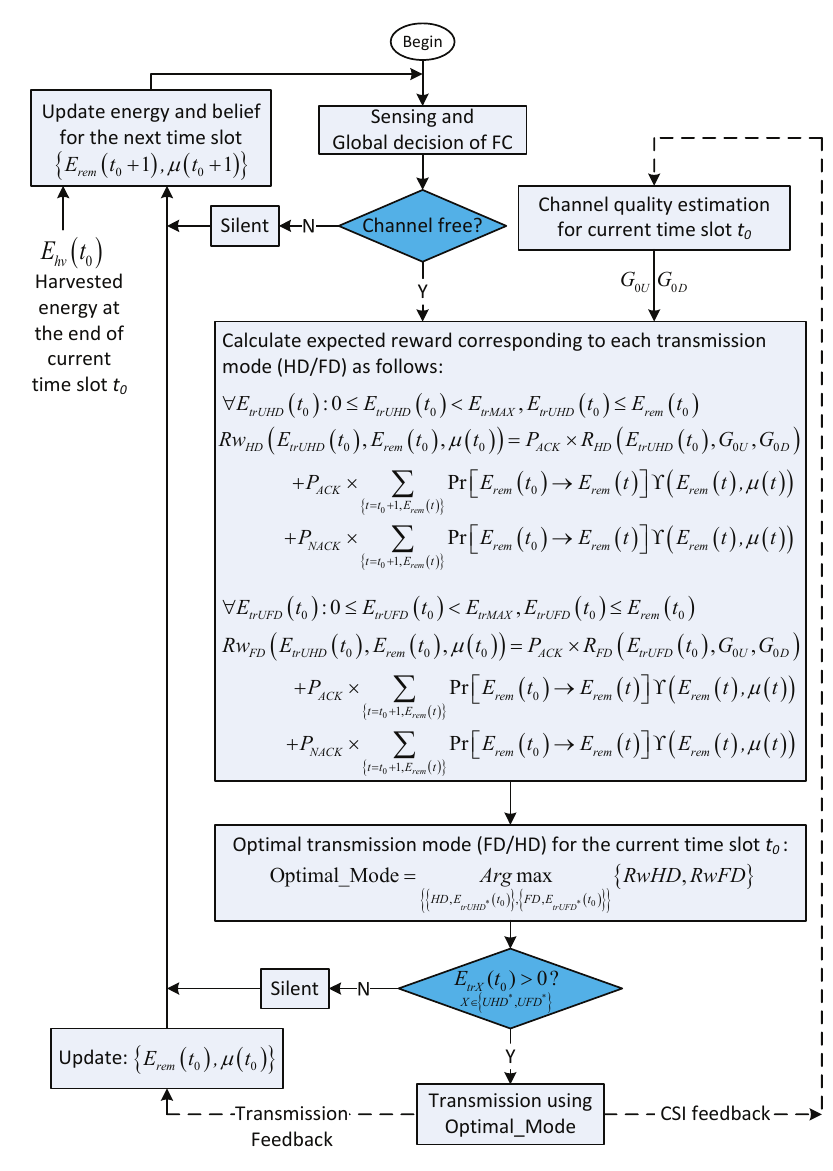
Figure 5. Flowchart for the operation of cognitive-user–base-station (CU–BS) transmission